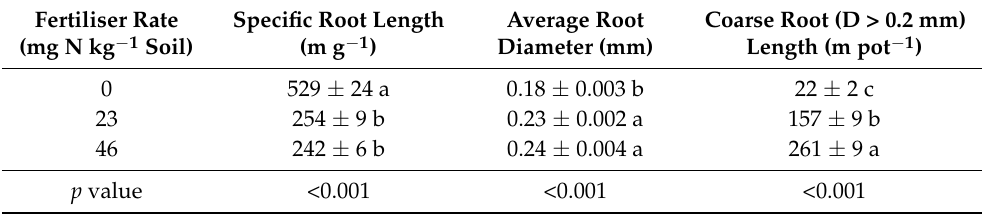
Table 6. Specific root length, root diameter and coarse root length as influenced by fertiliser rate (mean ± SE). Mean values within a column followed by different letters differ significantly. Three-way ANOVA (Table 3) showed no significant interaction, with the main effects of fertiliser rate being significant. The data on each fertiliser rate were averaged across two fertiliser types and two microbial inoculant treatments (n = 16). D, average root